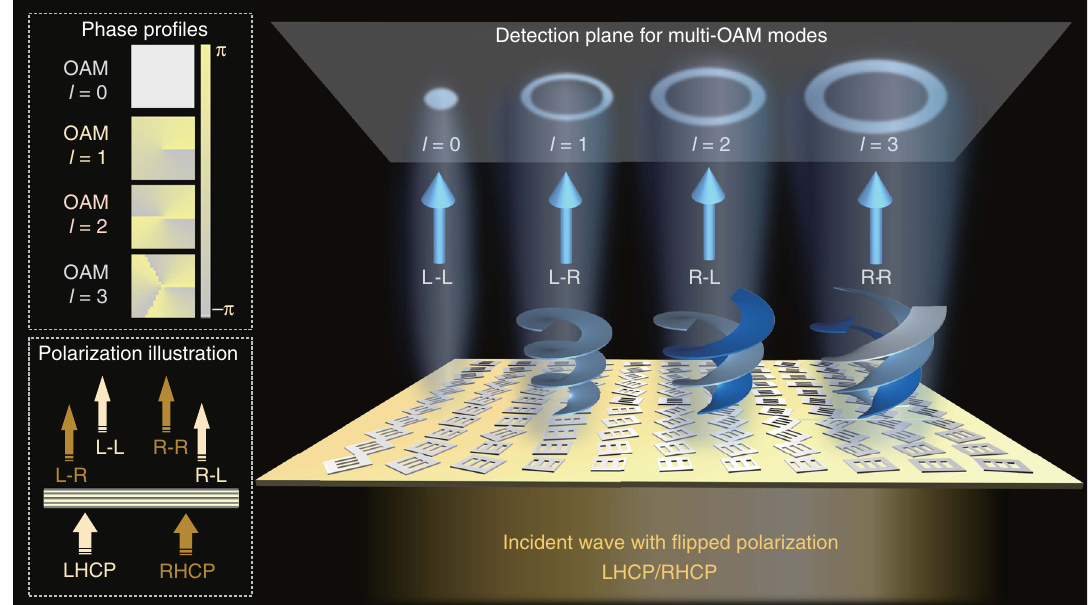
Fig. 1 Schematic principle of proposed metasurface device for complete phase-modulation in quadruplex polarization channels. Four vortex beams carrying OAM modes with l = 0, 1, 2, 3 are generated through L – L, L – R, R – L, R – R channels, respectively. The insets show the phase pro fi les of required OAM modes and the illustration of CP